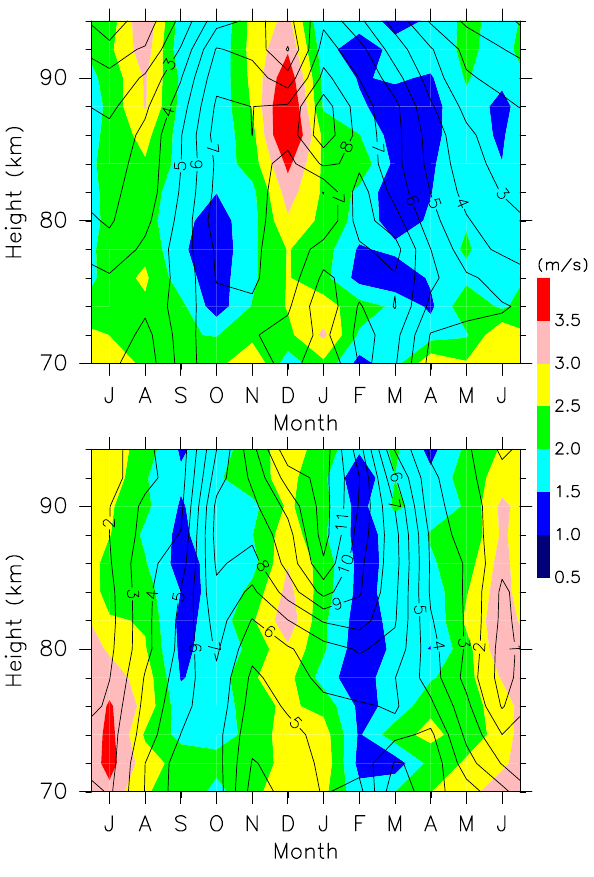
Fig. 5. Time-height sections of meridional momentum flux due to diurnal tide at the latitude of Syowa computed from the MF radar (top) and GSWM-02 data (bottom). Contour intervals are 2m 2 s − 2 . Colors represent 1 σ errors of meridional momentum